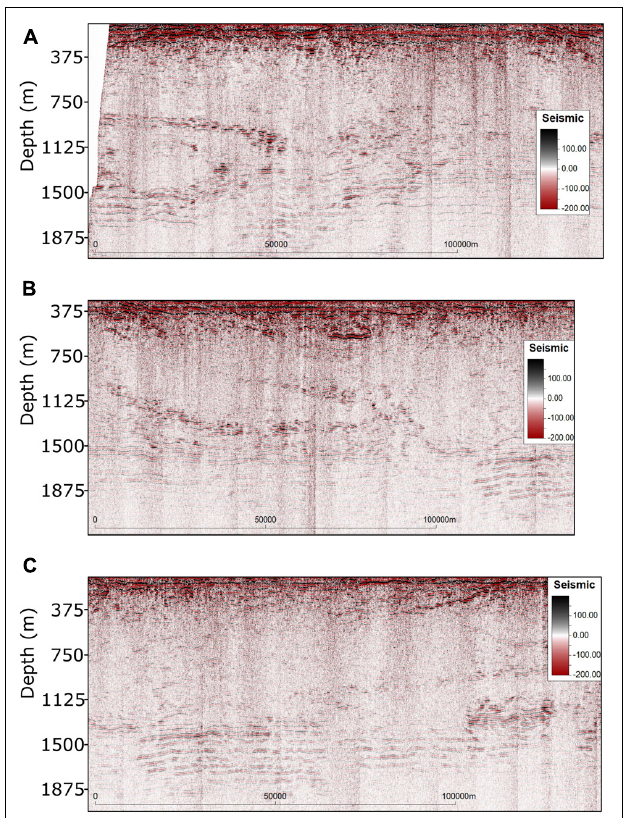
FIGURE 10 | Close-up of: (A) the eddy interpreted in the Western part of the profile; (B) elliptical shallow feature and oblique reflection within the MOW;